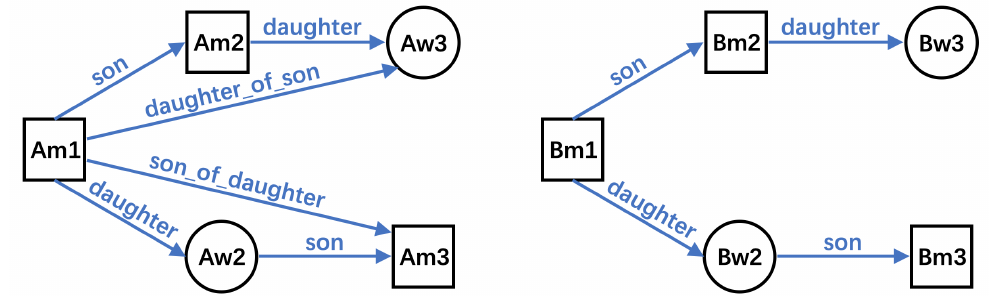
Figure 2. The structure of the training KG, where each directed edge represents a